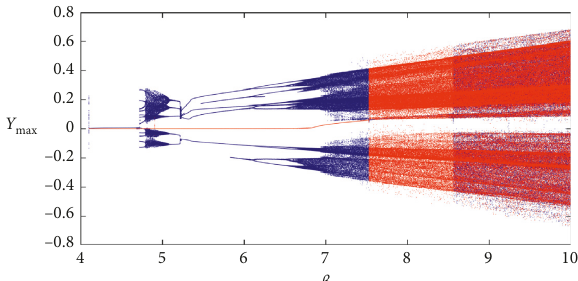
Figure 4: Maximum of ASHS with forward (red) and backward (blue)